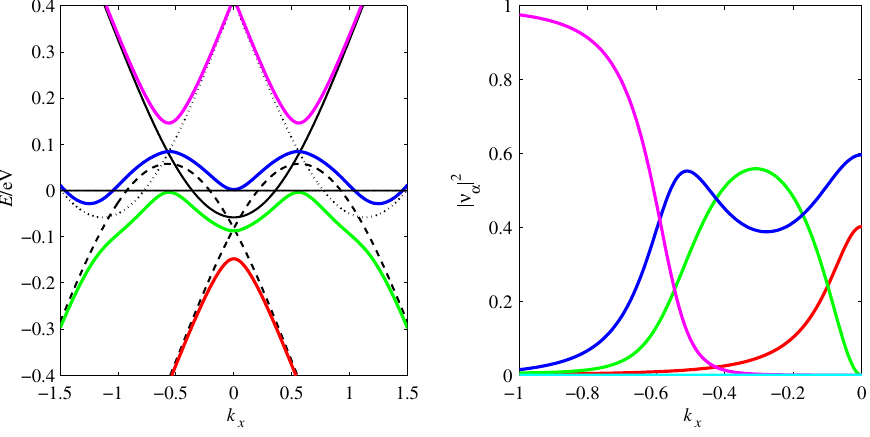
FIG. 9. (a) Plot of the energy bands of the five-band model defined by Eq. (5) for k y ¼ π . The dashed lines show − ð ε − k − μ Þ . (b) The spectral weight of the bands. The parameters used are the same as in Fig. 3, with the band dotted line shows ð ε k (cid:2) 2 Q parameters taken from Ref. [12].